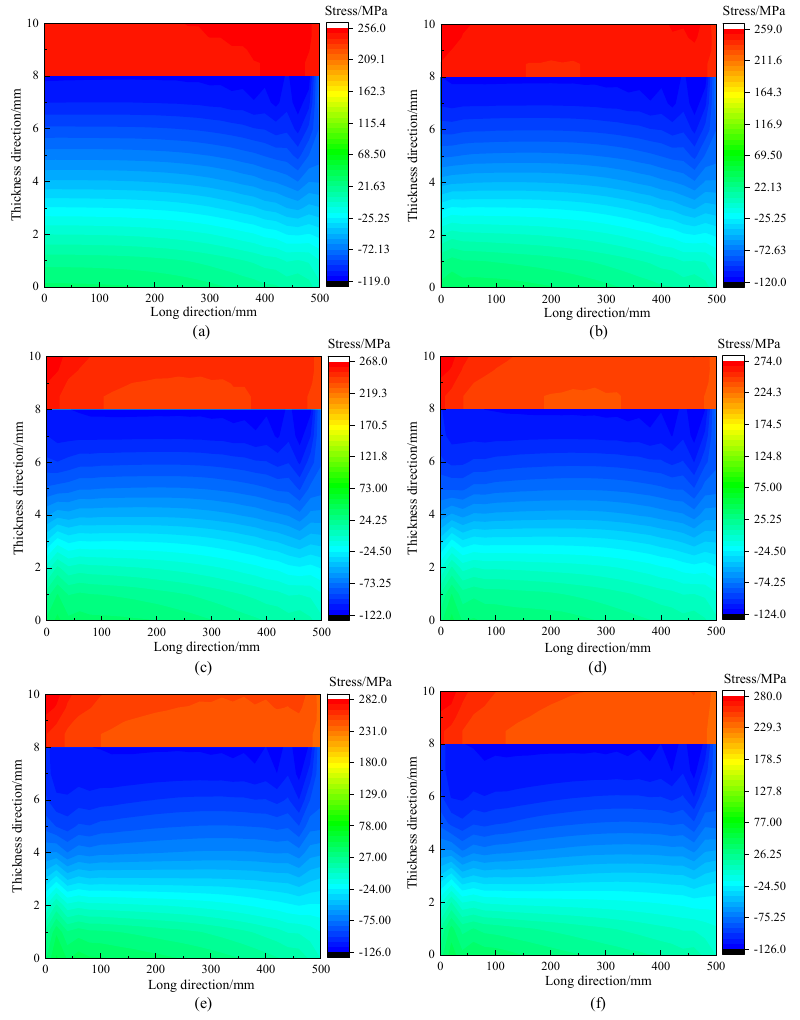
Figure 20. The residual stress distribution of 316L/Q235B composite plate under different tensile load parameters. ( a ) 0 MPa; ( b ) 2 MPa; ( c ) 4 MPa; ( d ) 6 MPa; ( e ) 8 MPa; ( f ) 10 MPa.